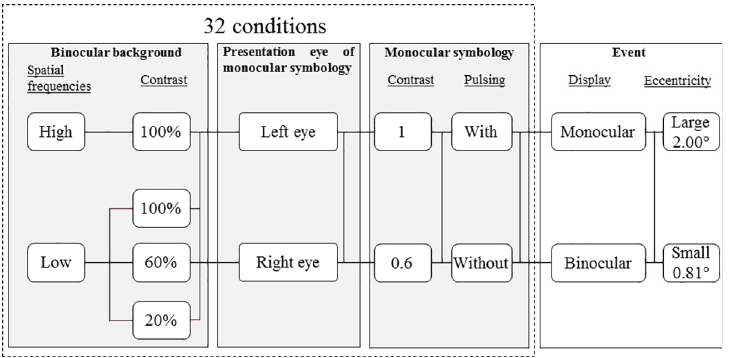
Fig 8. The 32 tested conditions. The independent variables that constitute these 32 conditions comprise binocular background and monocular element characteristics and display eye. In each condition, Landolt rings characteristics were also